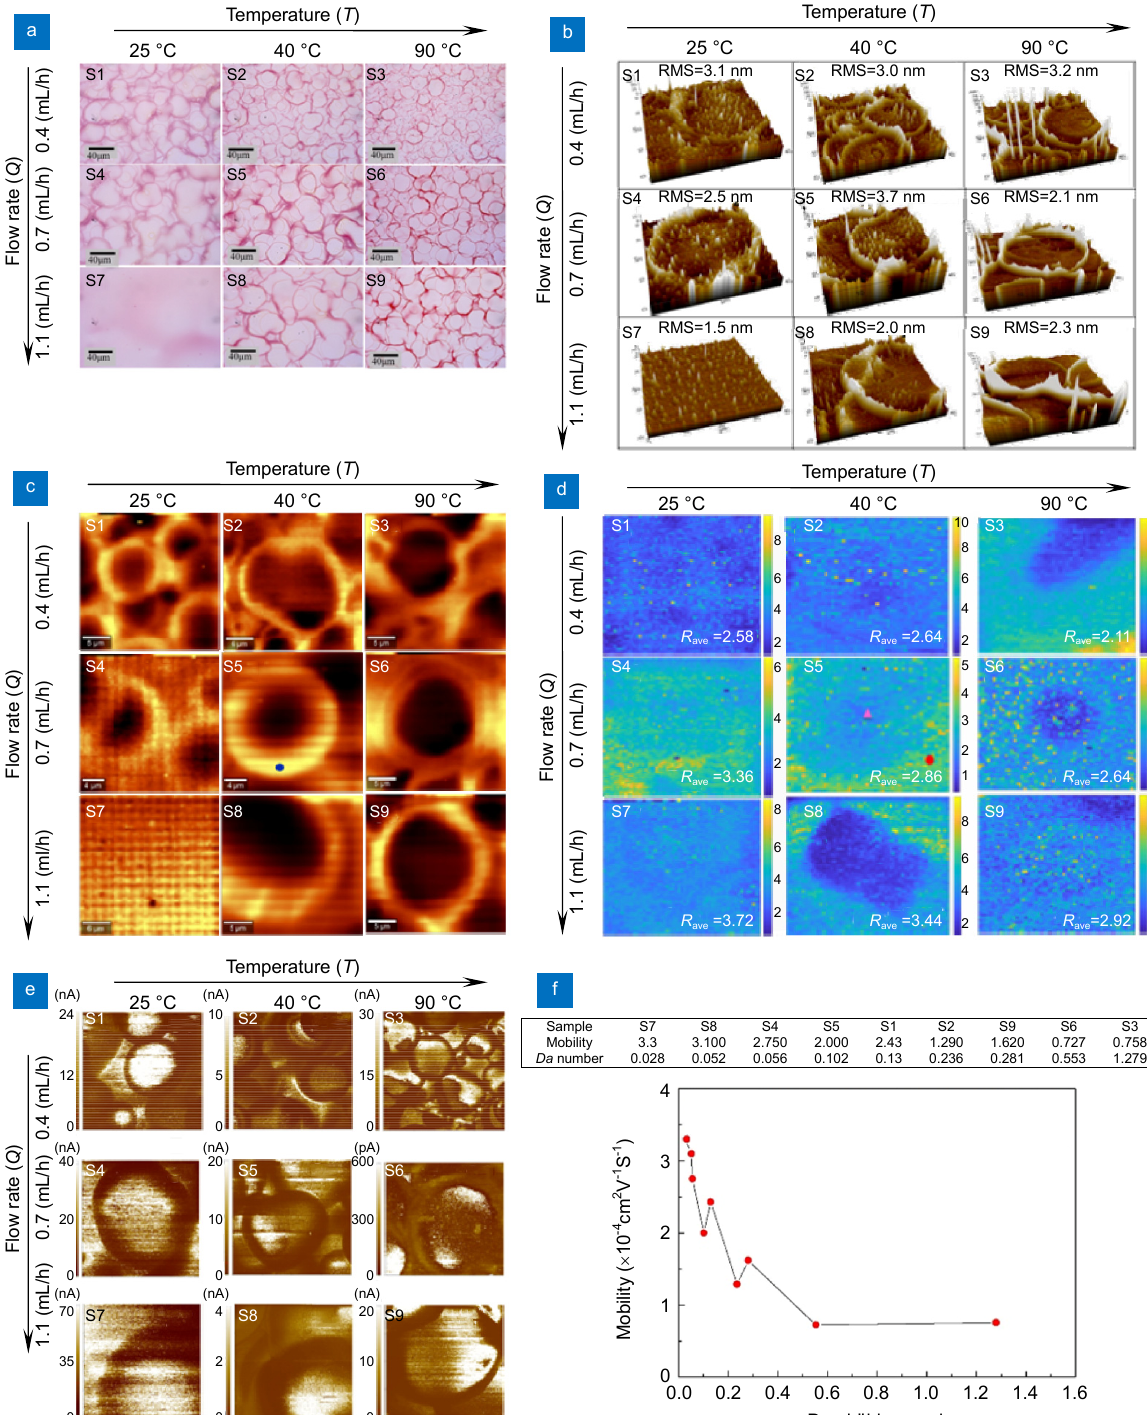
Fig. 7 | Surface morphology of continuous thin films by electrospray at various flow rates and substrate temperatures (thickness of thin films is ~200 nm) 22 . (a) Optical microscopy images. (b) AFM images. (c) Raman intensity distribution. (d) Ratio images of Lorentzian components ( R ) derived from the Raman spectra, R ave : average R value. (e) Current density map by C-AFM and (f) carrier mobility vs. Da